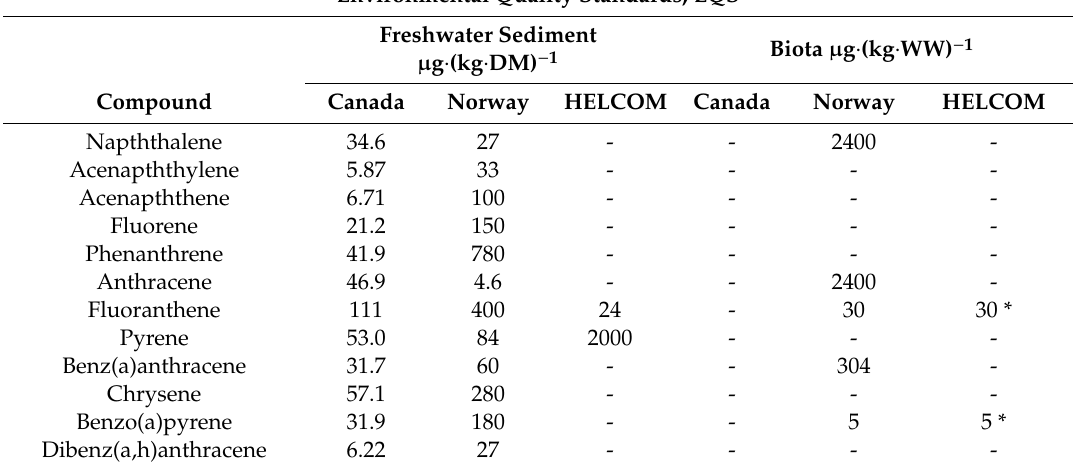
Table 2. Environmental quality standards from Canada, Norway and the Helsinki Commission (HELCOM) for the Baltic Sea